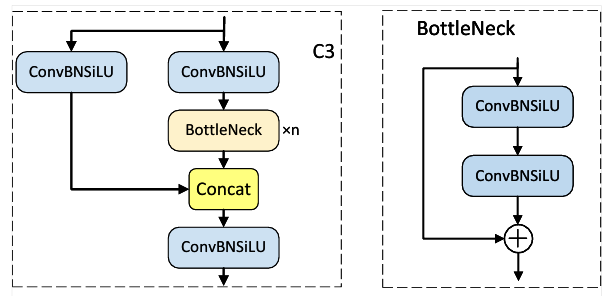
Figure 3. Illustration of the architecture of the C3 module.